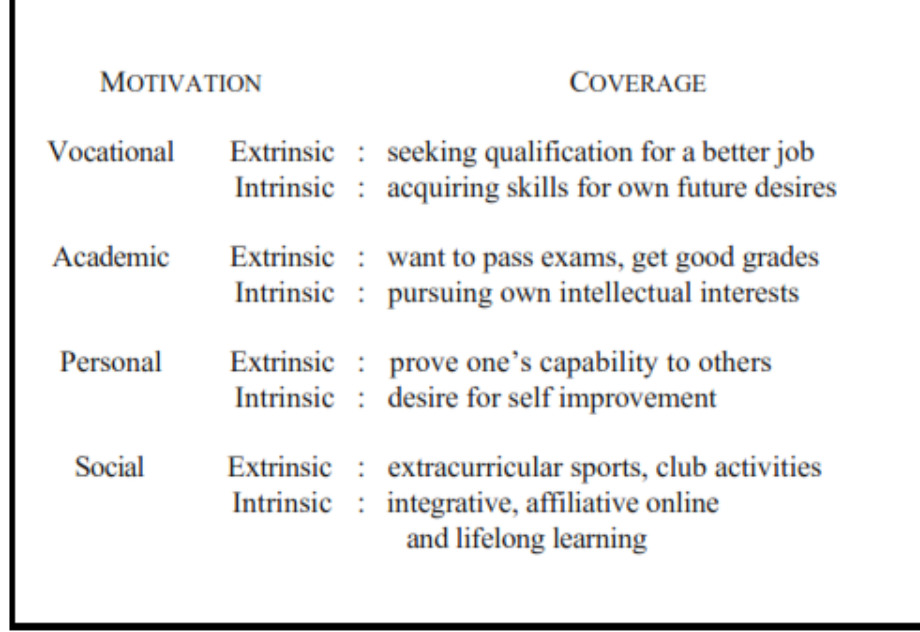
Figure 6 . The motivation to learn (Kawachi,